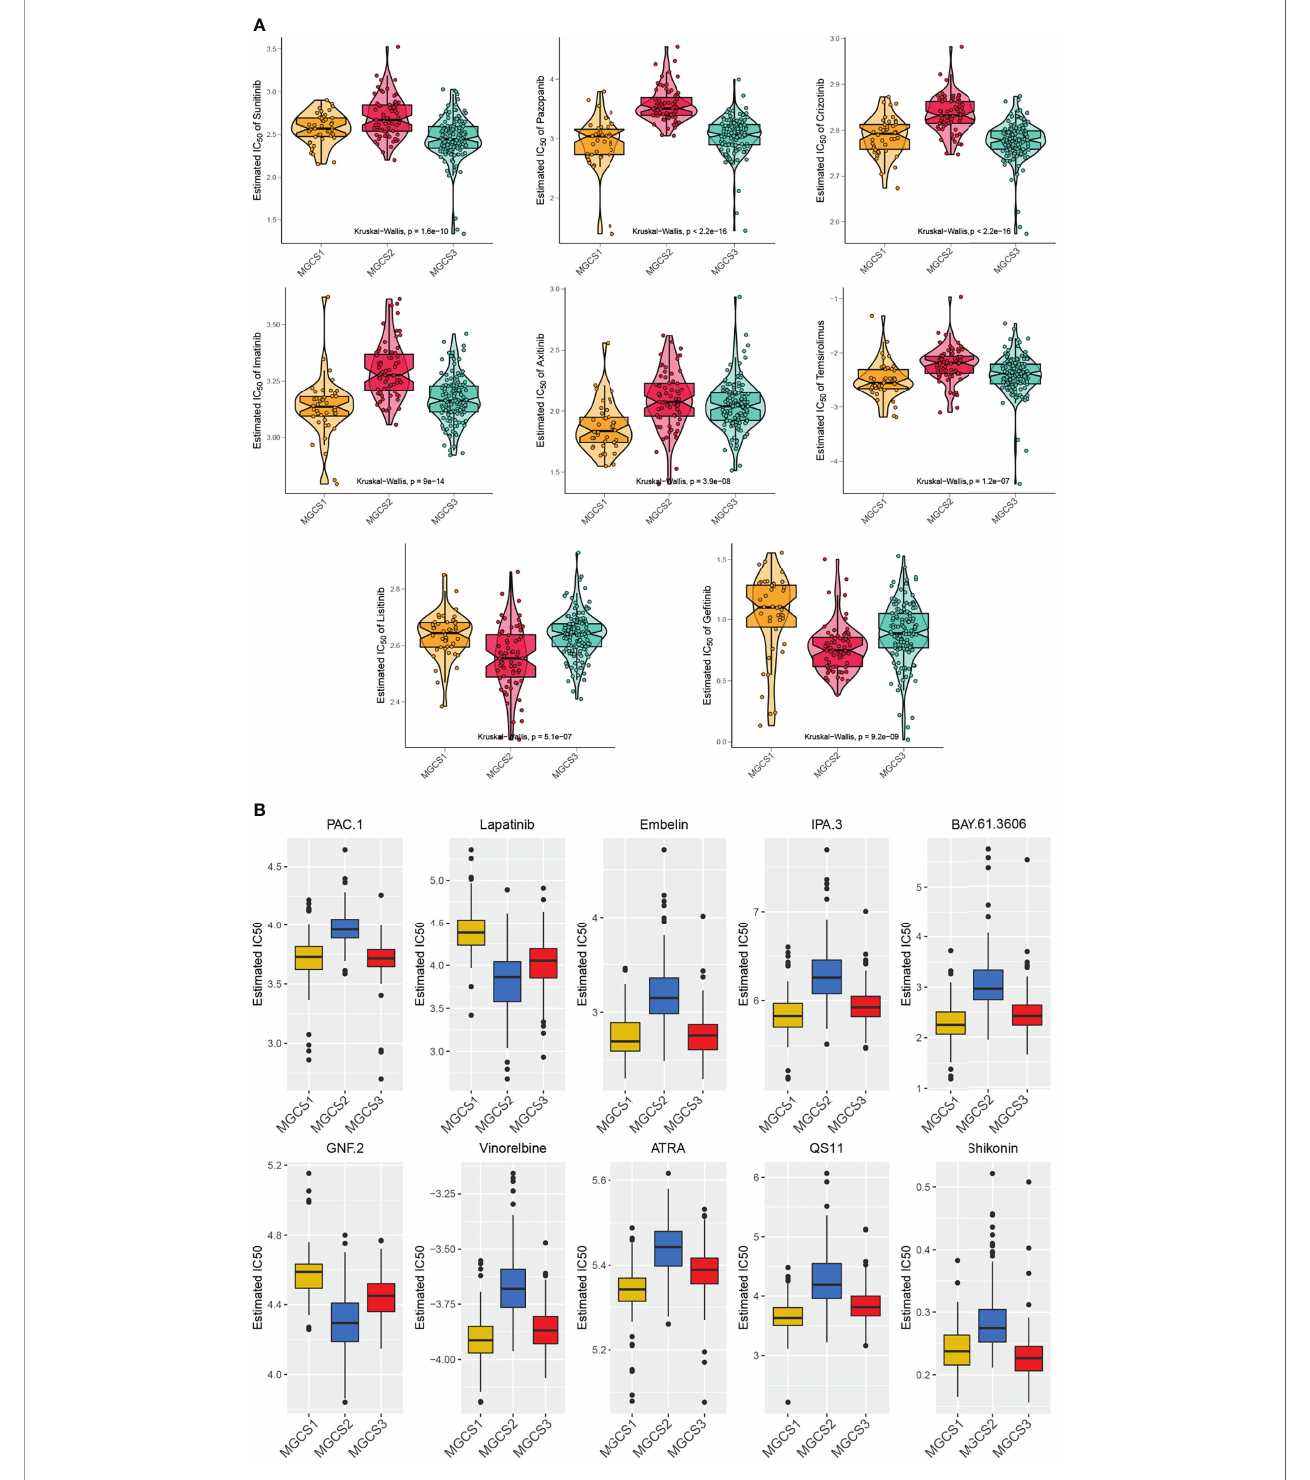
FIGURE 6 | Comparison of drug sensitivity. (A) Estimated IC50 of the indicated molecular targeted drugs in MGCS1, MGCS2, and MGCS3. (B) Estimated IC50 of the potential drugs in MGCS1, MGCS2, and